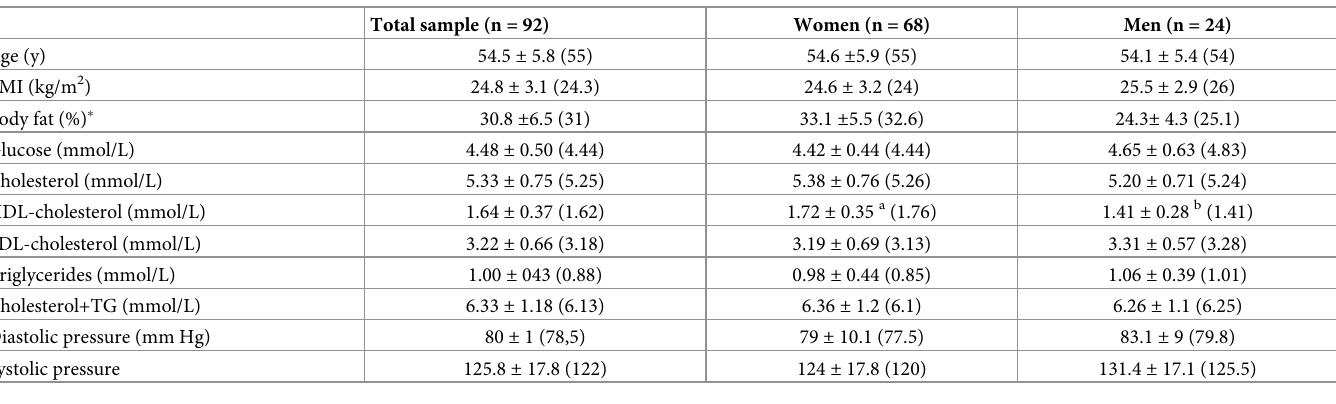
Table 1. Characteristics and lipid profile (mmol/L).